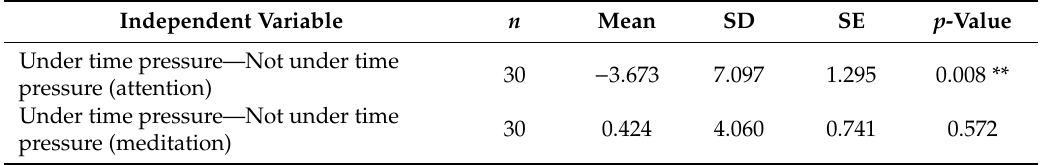
Table 7. Paired t -test results for attention and meditation levels.